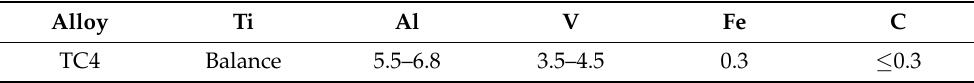
Table 2. Chemical composition of TC4 alloy [wt.%].